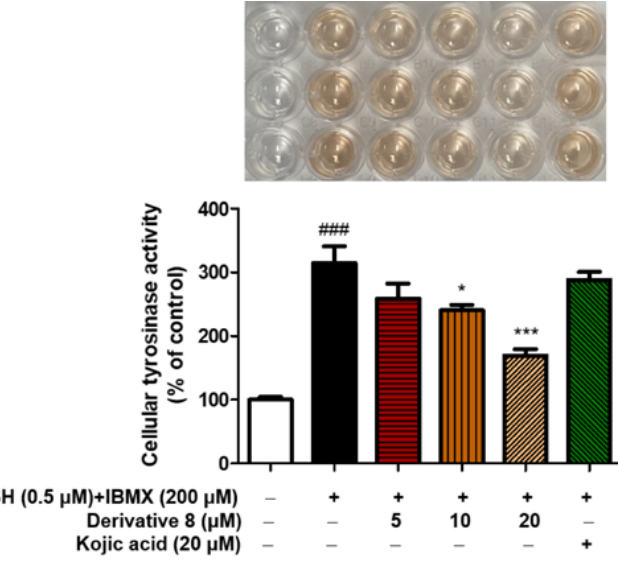
Figure 9. Inhibitory effects of BABT derivative 8 on cellular tyrosinase activity in B16F10 murine melanoma cells. After 1 h exposure of B16F10 cells to derivative 8 at four different concentrations (0, 5, 10, and 20 µ M), the cells were treated with a stimulator (0.5 µ M α -MSH plus 200 µ M IBMX) to increase melanogenesis. After 72 h of incubation, cellular tyrosinase activity was analyzed by measuring the optical density at a wavelength of 475 nm. Kojic acid at 20 µ M was used as a positive reference control. All experiments were performed independently, thrice. Symbols (* and # ) are used to indicate the significant differences between columns. ### p < 0.001 for cells treated with a stimulator vs. untreated control; * p < 0.05, *** p < 0.001 for cells treated with a stimulator plus derivative 8 or kojic acid vs. cells treated with a stimulator only. Results are represented as the mean ± SEM of three independent experiments.